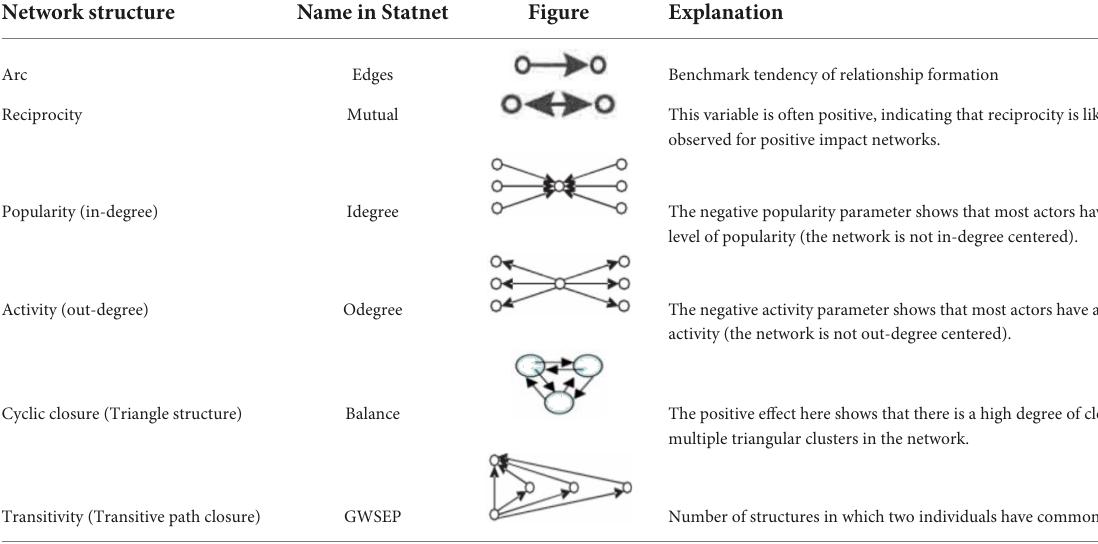
TABLE 2 The structural elements in the exponential random graph model (ERGM). Network structure Figure Explanation